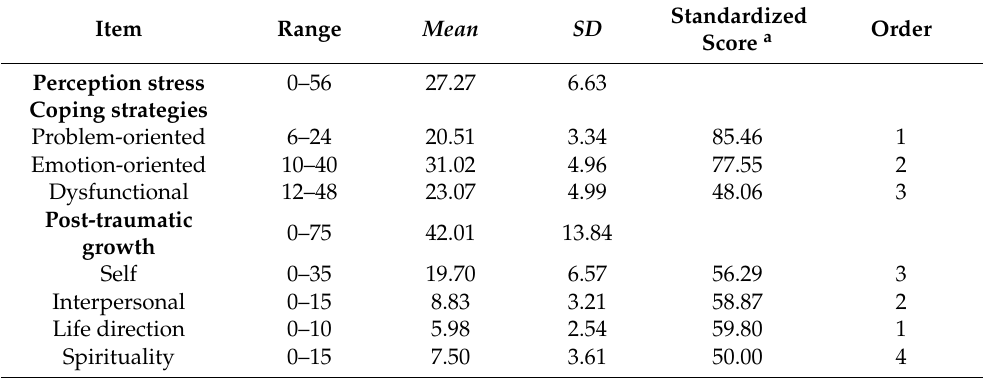
Table 2. Analysis of perceived stress, coping strategies, and post-traumatic growth of primary caregivers.